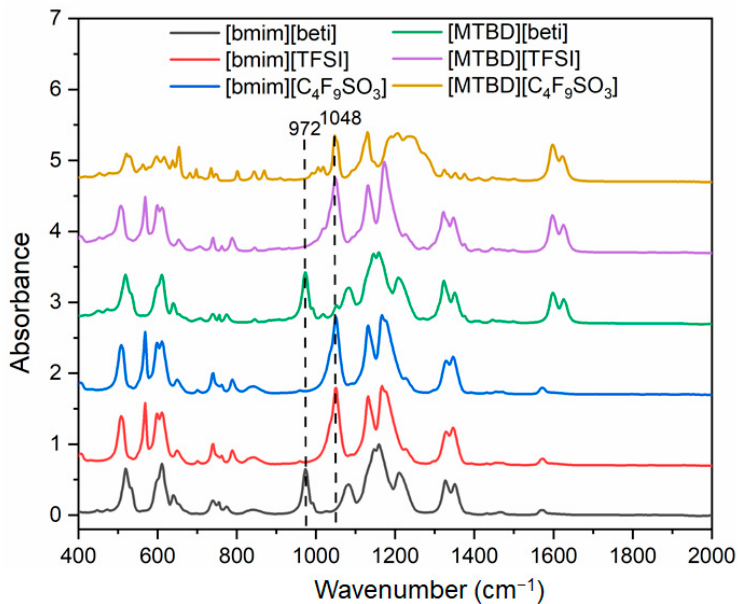
Figure 2. ATR-FTIR spectra of [bmim][beti], [bmim][TFSI], [bmim][C 4 F 9 SO 3 ], [MTBD][beti], [MTBD][TFSI] and [MTBD][C 4 F 9 SO 3 ].